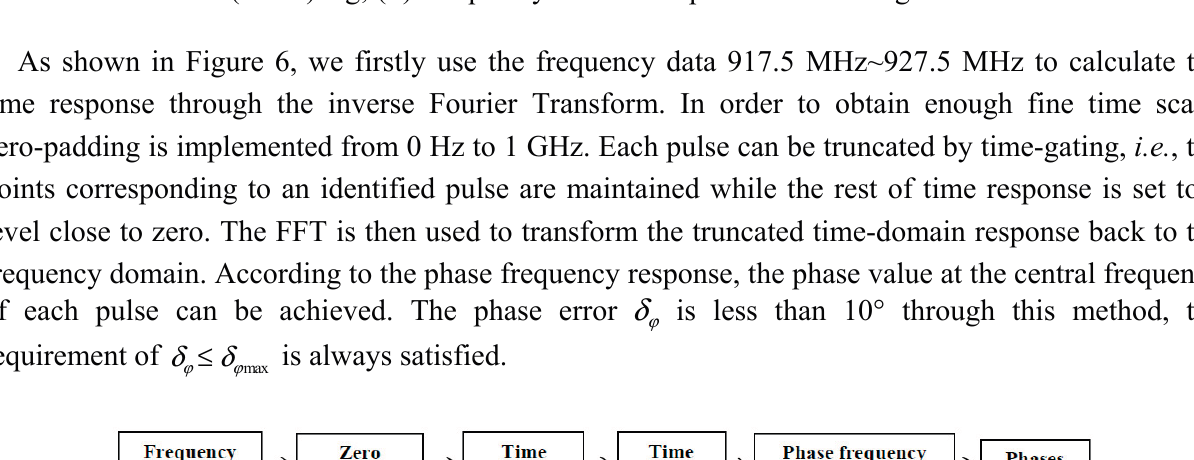
Figure 5. Measured S 11 of a SAW tag prototype. ( a ) Time-domain response of surface acoustic wave (SAW) tag; ( b ) Frequency-domain response of SAW tag.